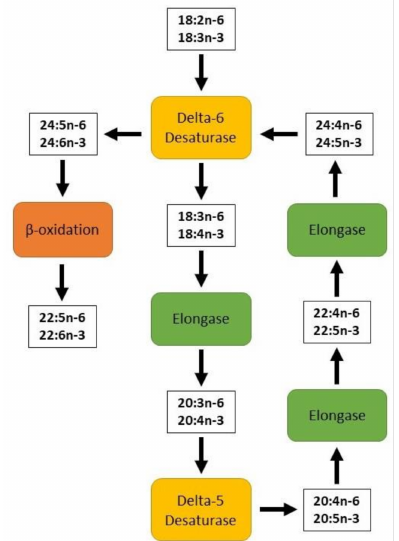
Figure 3. A diagram of omega-3 and omega-6 fatty acid elongation and desaturation to highlight the second use of delta-6 desaturase adapted from Gibson, Neumann, Lien, Boyd and Tu